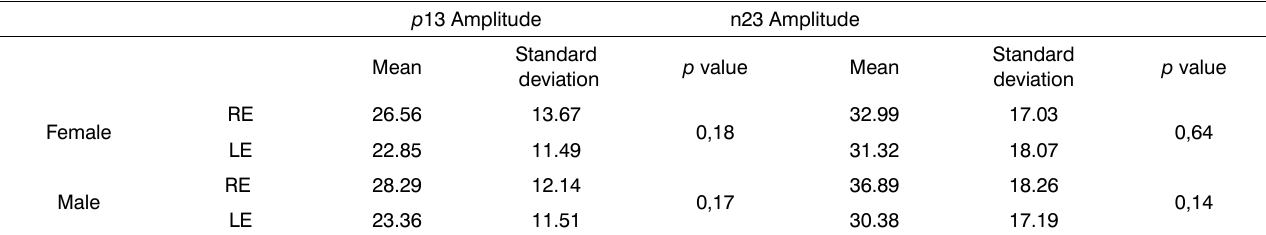
Table 2. Comparison of P13-N23 wave amplitudes (µV) in the right and left ears, in both sexes. p 13 Amplitude